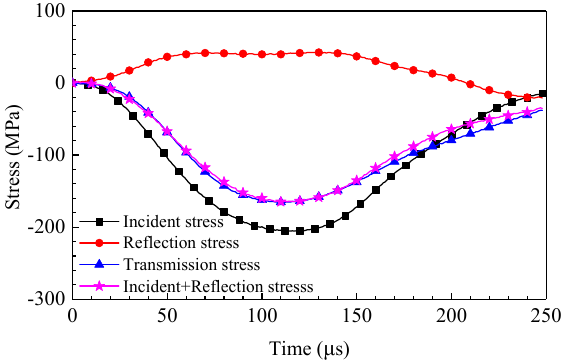
Figure 6. Dynamic stress balance checkout of specimen (20 °C, 0.8 MPa).